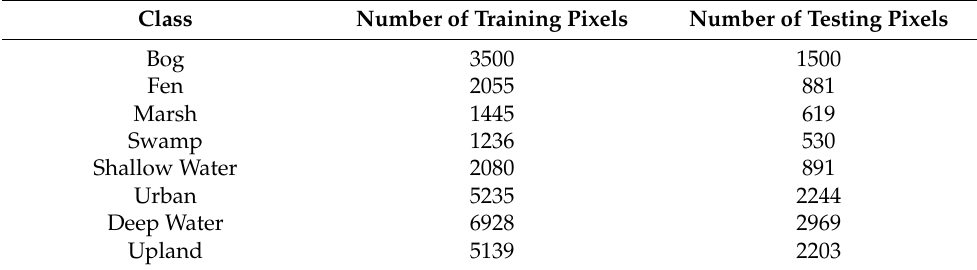
Table 1. Training and testing pixel of wetland samples in the study area of Avalon, Canada.